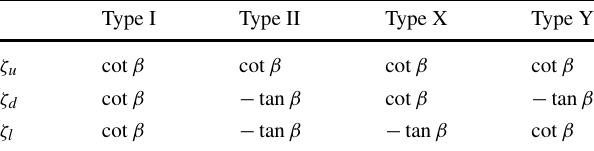
Table 1 Values of the alignment parameters ζ f for different types of Two-Higgs Doublet Models Type